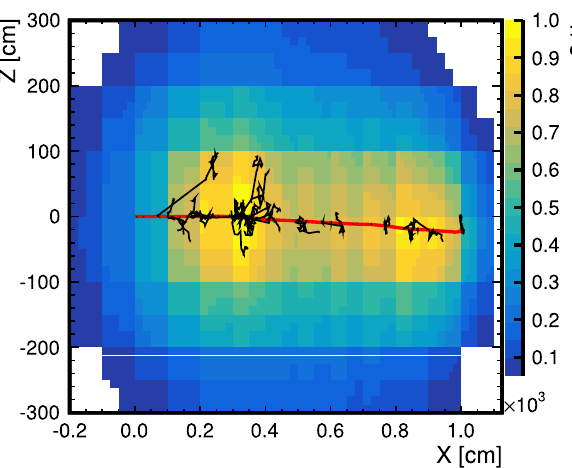
Fig. 2 Reconstruction results for a simulated muon with 3 GeV ini- tial kinetic energy in the cylindrical LENA detector projected along the symmetry axis (left) or a radial y -axis (right). The primary particle started at ( 0 , 1000 , 0 ) cm in the direction ( 1 , − 1 , 0 ) . Both the pro-